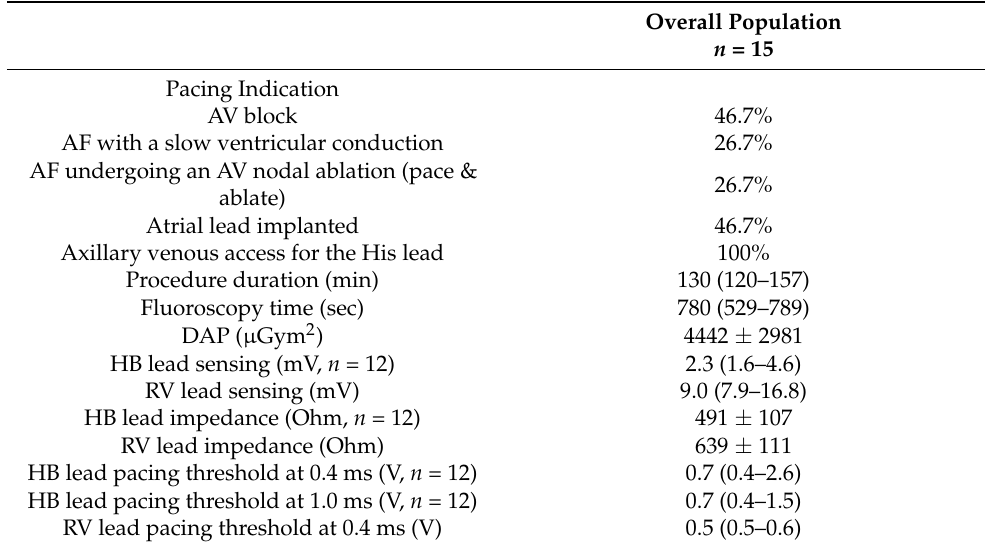
Table 2. Procedural